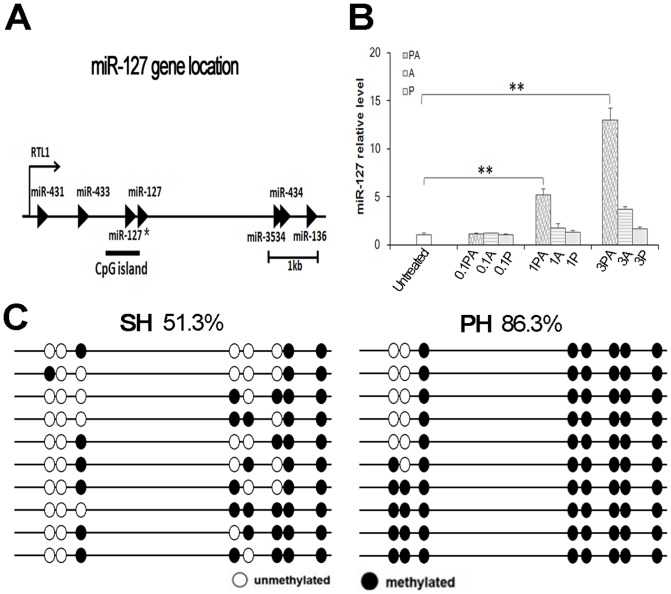

MiR-127 is induced from its promoter by DNA demethylation and histone deacetylase inhibition.(A) Schematic representation of the CpG island on the promoter region of the miR-127 gene. (B) MiR-127 is highly induced by 5-Aza-CdR and PBA treatment. BRL-3A cells were treated with 5-Aza-CdR and/or PBA, and the miR-127 expression level was analyzed by qRT-PCR. U6 RNA expression was used as a loading control. 0.1A, 0.1 μmol/L 5-Aza-CdR; 1A, 1 μmol/L 5-Aza-CdR; 3A, 3 μmol/L 5-Aza-CdR; 0.1P, 0.1 mmol/L PBA; 1P, 1 mmol/L PBA; 3P, 3 mmol/L PBA; 0.1AP, combination of 0.1 μmol/L 5-Aza-CdR and 0.1 mmol/L PBA; 1AP, combination of 1 μmol/L 5-Aza-CdR and 1 mmol/L PBA; 3AP, combination of 3 μmol/L 5-Aza-CdR and 3 mmol/L PBA. Data from three independent experiments are shown as the means ± SD. (**P<0.01). (C) The CpG island was hypermethylated 24 h after partial hepatectomy (PH). Genomic DNA was obtained from rat liver tissues 24 h after PH or sham operation (SH), the DNA methylation status was determined by bisulfite genomic sequencing (P<0.01, Wilcoxon rank-sum test).